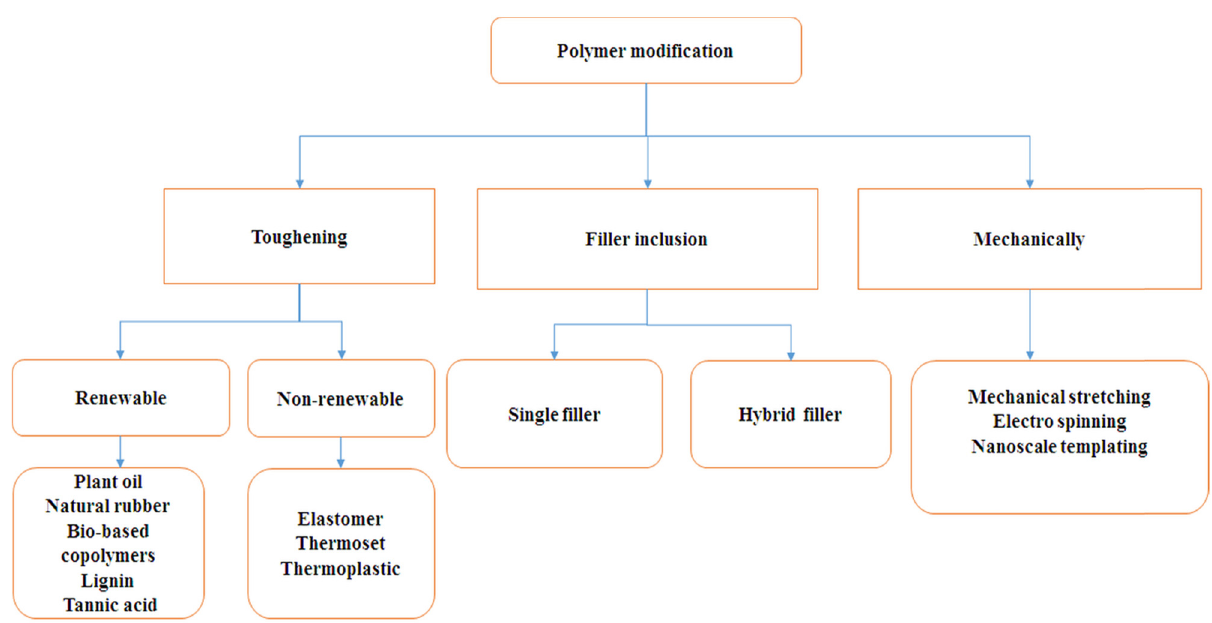
Figure 4: Di ff erent methods for polymer modi fi cation.